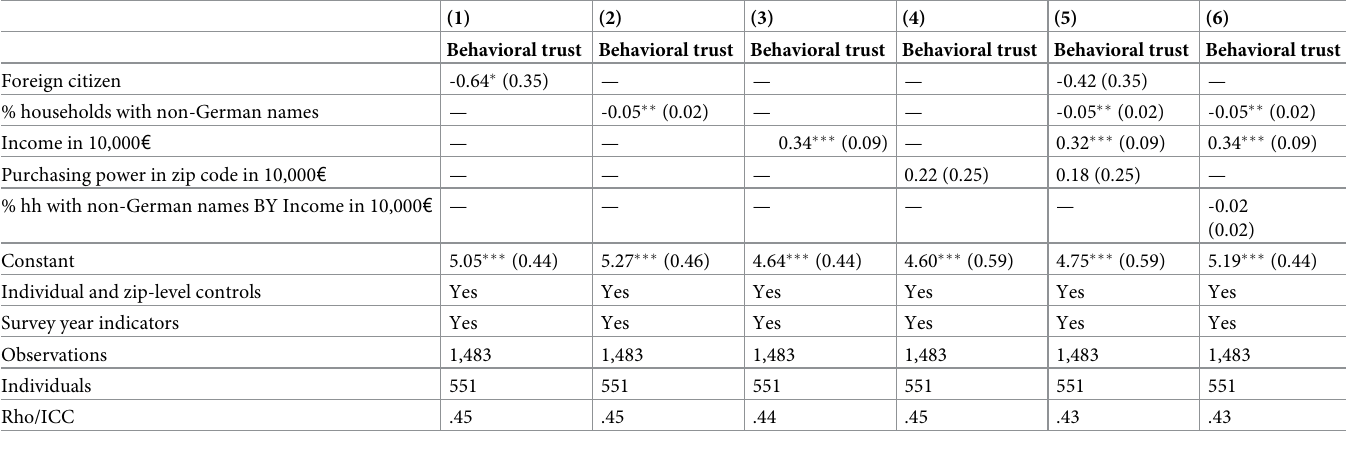
Table 2. Behavioral trust conditional on individual- and zip-code-level indicators of socio-economic status and ethnic